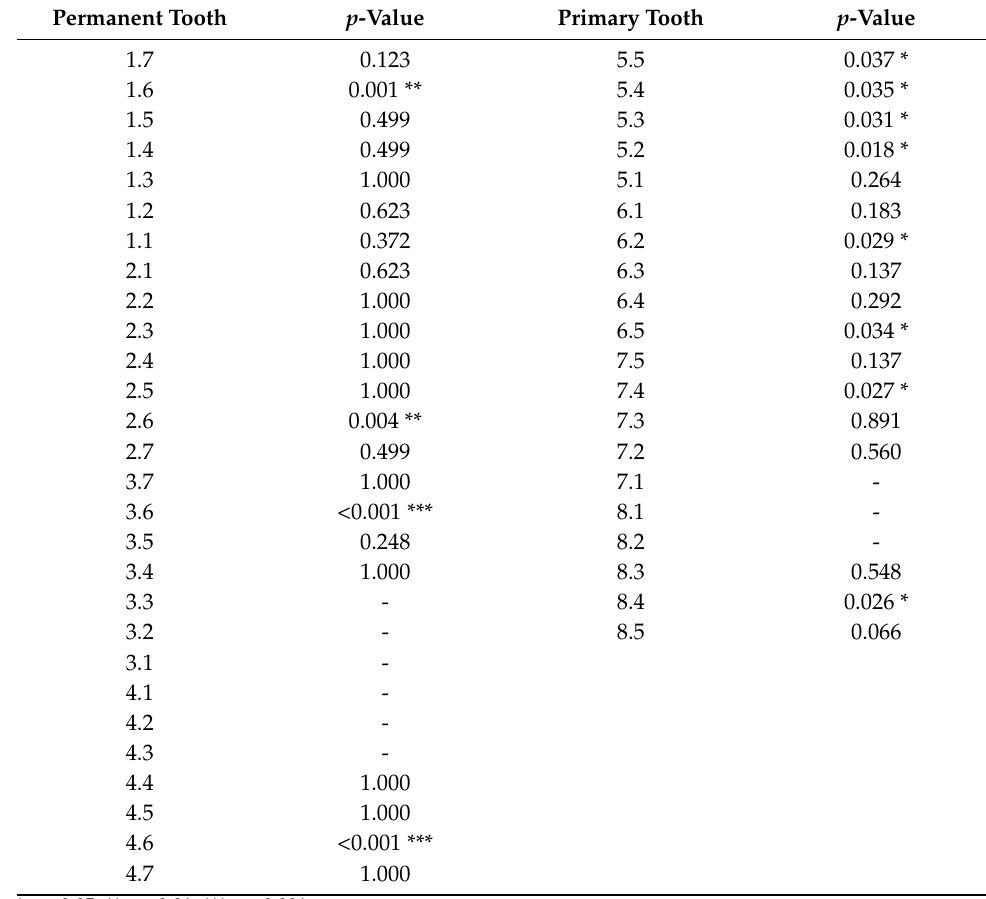
Table 1. Caries prevalence for each tooth and adherence to the Mediterranean diet (medium–low vs. high).